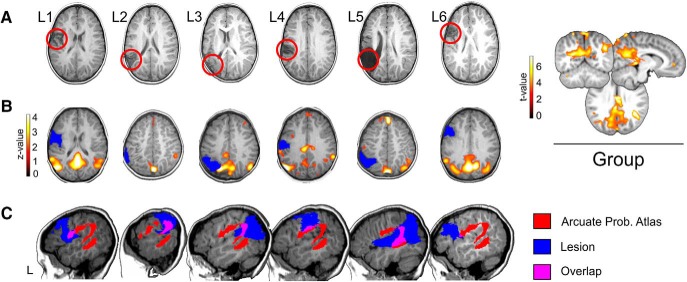

A, Depiction of the structural lesions in native space using a T1-w axial image. The lesions can be seen as hypo-intense areas and are highlighted with a red circle. Neurologic convention is used. B, Individual DMNs for each patient, obtained using group spatial ICA on the resting state data (see Materials and Methods). Individual data are in z-scores (p < 0.05, uncorrected) and presented over each patient’s T1 registered to a common space (four-year-old MRI brain template obtained from the Neurodevelopmental MRI Database; see Materials and Methods). This was done as a demonstration of data quality, given that propofol can reduce connectivity in cortical areas of significance for the current study (Boveroux et al., 2010). On the right, the average DMN for all patients is depicted, using t values (p < 0.01, uncorrected) over a canonical four-year-old MRI brain template. C, Probability templates for the left arcuate (anterior, posterior, and long segment) were extracted from the Tractotron atlas (Thiebaut de Schotten et al., 2011; Rojkova et al., 2016), thresholded at a 80% (only voxels having a 80% probability of being part of the AF according to the atlas are shown) and registered to a common space (the four-year-old MRI brain template obtained from the Neurodevelopmental MRI Database). For each patient, here we depict the arcuate probabilistic atlas (in red), the lesion (in blue), and the overlap between them (in pink) over a sagittal slice of the left hemisphere. Neurologic convention is used. L, left hemisphere.